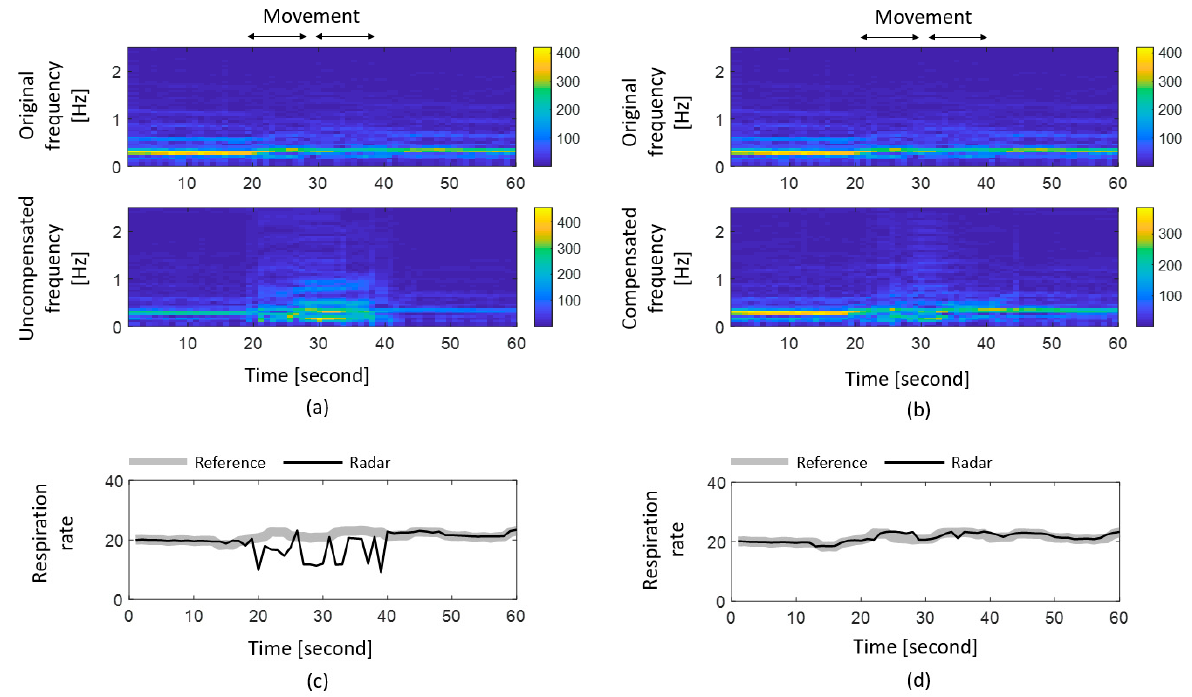
Figure 5. Compensation results comparison. ( a , b ) Frequency components of driver’s respiration signal, ( c , d ) estimated respiratory rate.